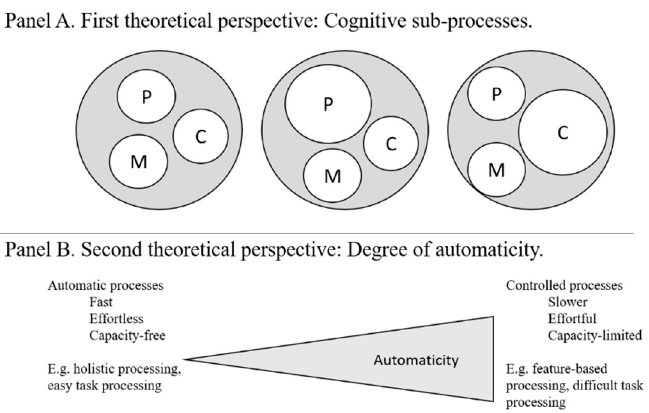
Figure 2. ( Panel A ): Illustration of variance components of cognitive sub-processes needed in different magnitudes depending on the task characteristics. This is to say that tasks rely to different degrees on cognitive sub-processes. Performance variance in a task (grey circle) can be decomposed into variable components related to sub-processes of cognition: P—perceptual processes; C—central cognitive processes; M—motor response-related cognitive processes; remaining grey area representing measurement error and other cognitive processes. ( Panel B ): Illustration of automaticity as a task characteristic.